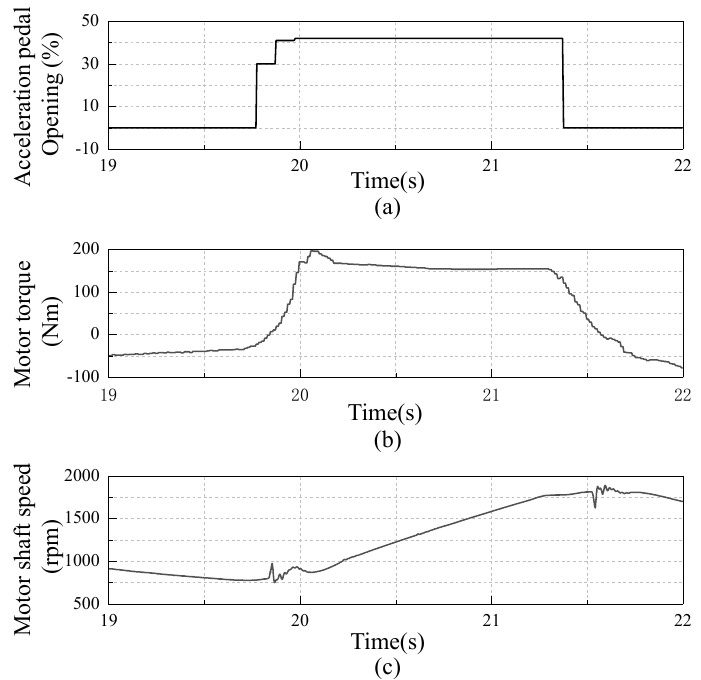
Figure 4. Typical signals for pedal tip-in/out operations. (( a ) Acceleration pedal opending. ( b ) Motor torque. ( c ) Motor shaft speed).